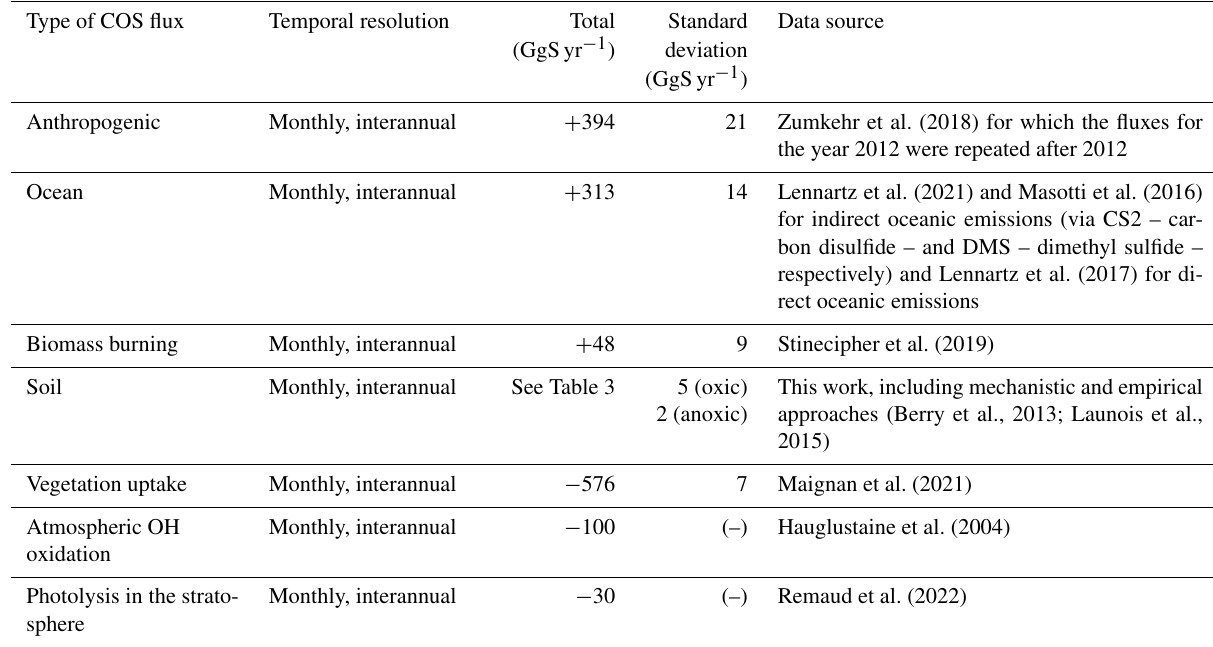
Table 2. Sink and source components of COS budget used in this study. Mean magnitudes and standard deviations of different types of fluxes are given for the period 2009–2016.